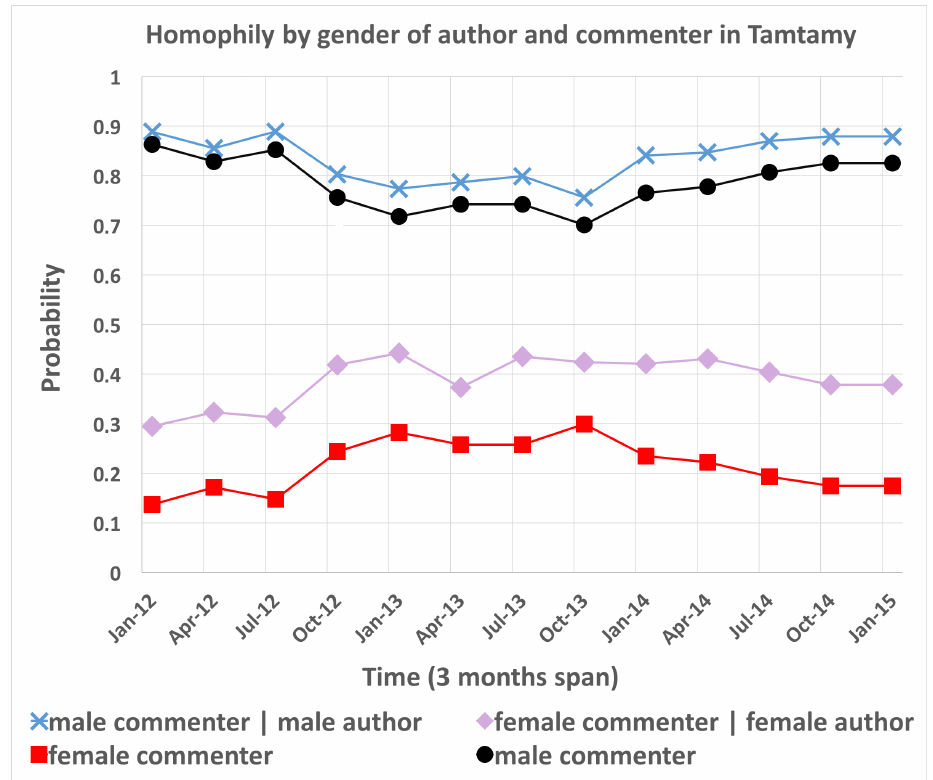
Figure 7. Gender homophily of commenters compared with prior probability of female and male commenters along the three